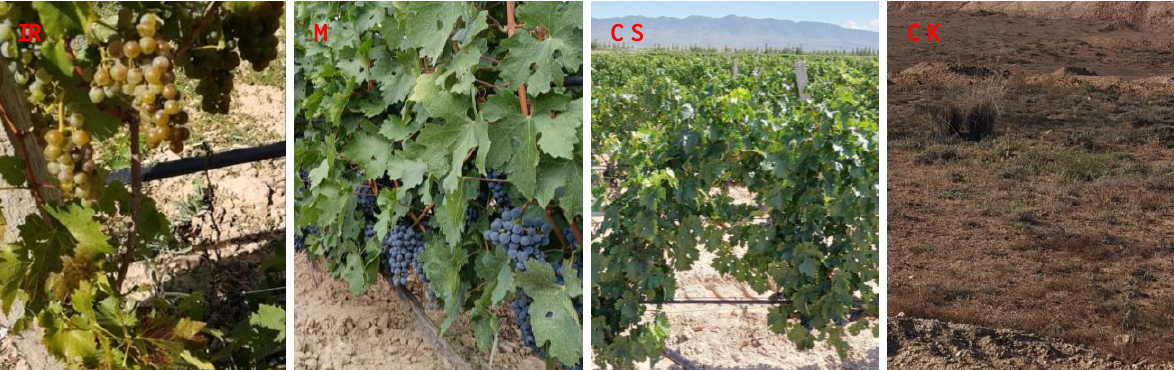
Figure 1. Selected vineyards and desertified soil sample plots. IR, Italian Riesling; M, Merlot; CS, Cabernet Sauvignon; CK, control check (desert land).